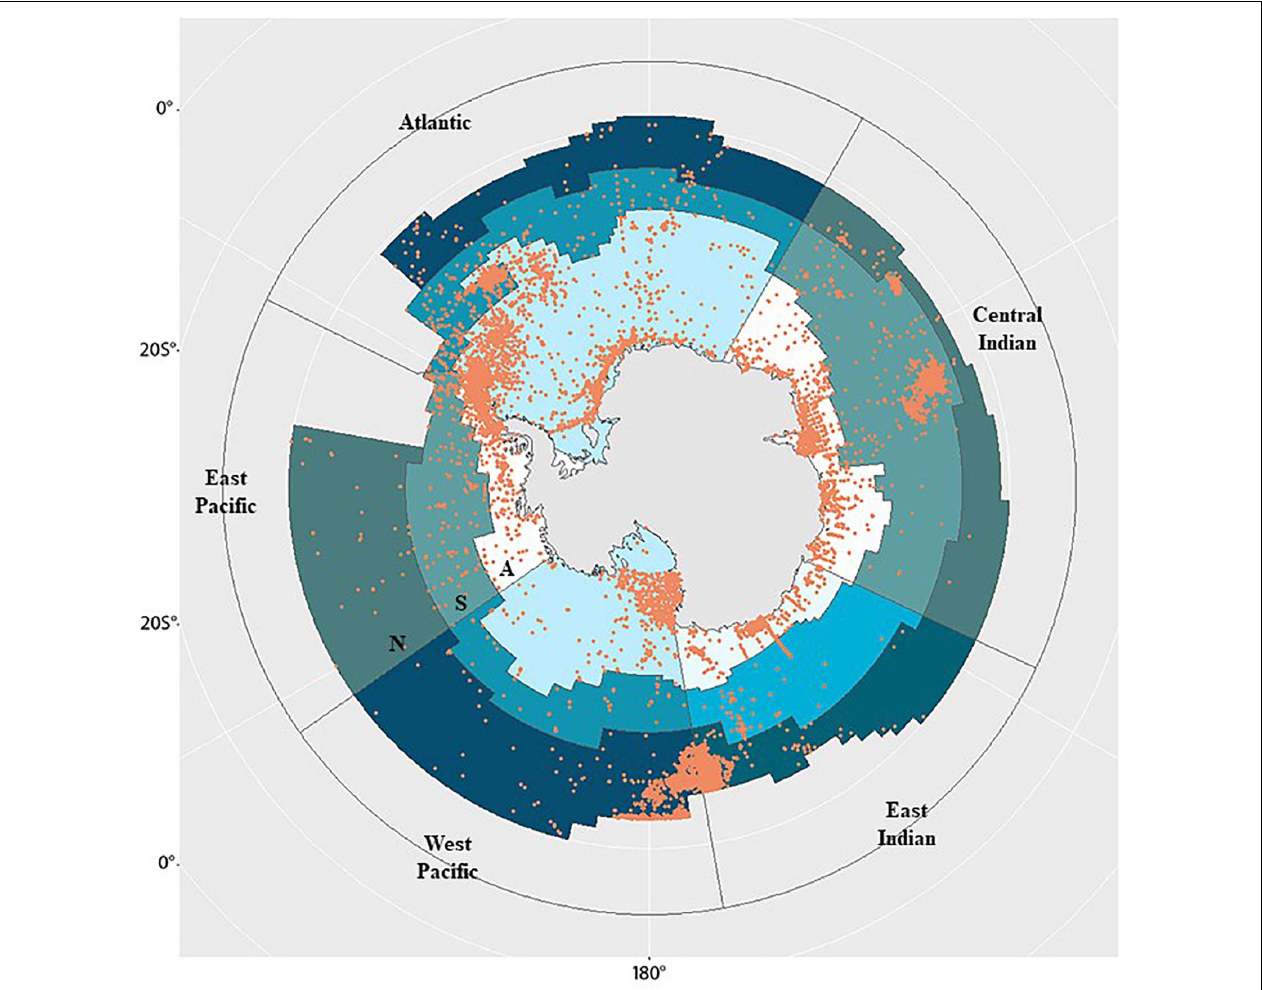
FIGURE 4 | The distribution of 161,711 distribution records (orange circles) belonging to 7,945 benthic species across size classes ( macro-, mega-, meio-fauna) extracted from Ocean Biogeographic Information System (OBIS) and Global Biodiversity Information Facility (GBIF). MEASO areas are shown including MEASO sectors (Atlantic, Central Indian, East Indian, West Pacific, East Pacific) and MEASO zones (where N = northern, S = subantarctic, A = Antarctic). Details regarding data analyses are provided in Supplementary Information